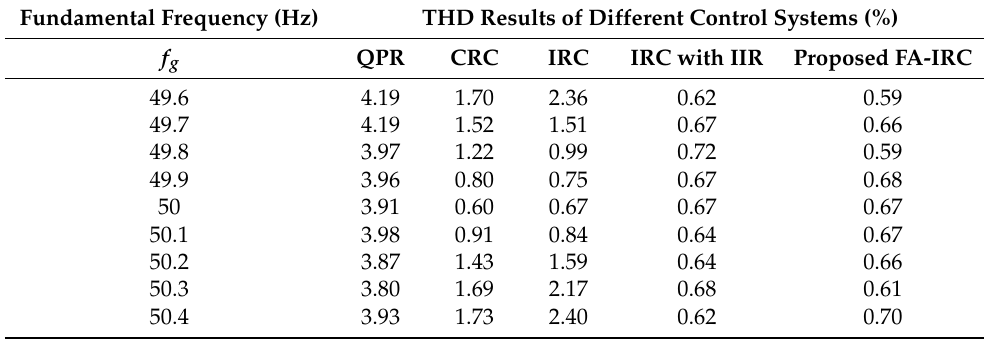
Table 4. THD results of different control systems under various fundamental frequencies.